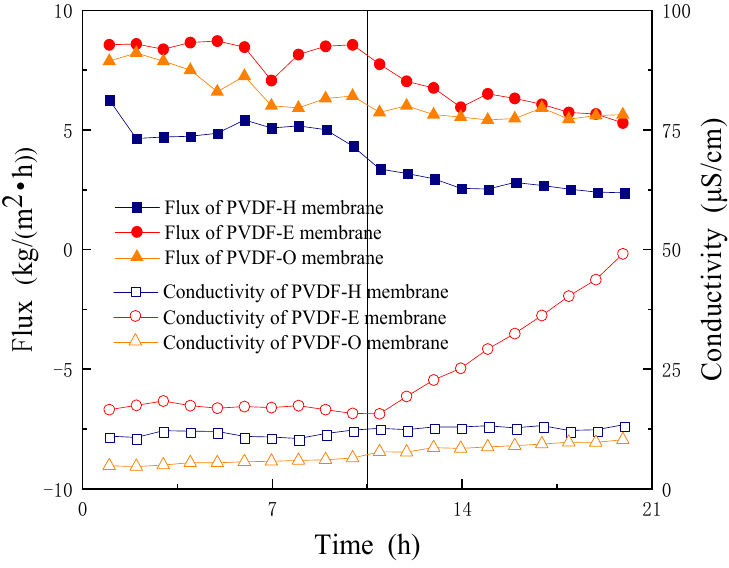
Figure 7. Flux and conductivity variation of PVDF-H, PVDF-E and PVDF-O membranes in the treatment of high-salinity mine water by DCMD.